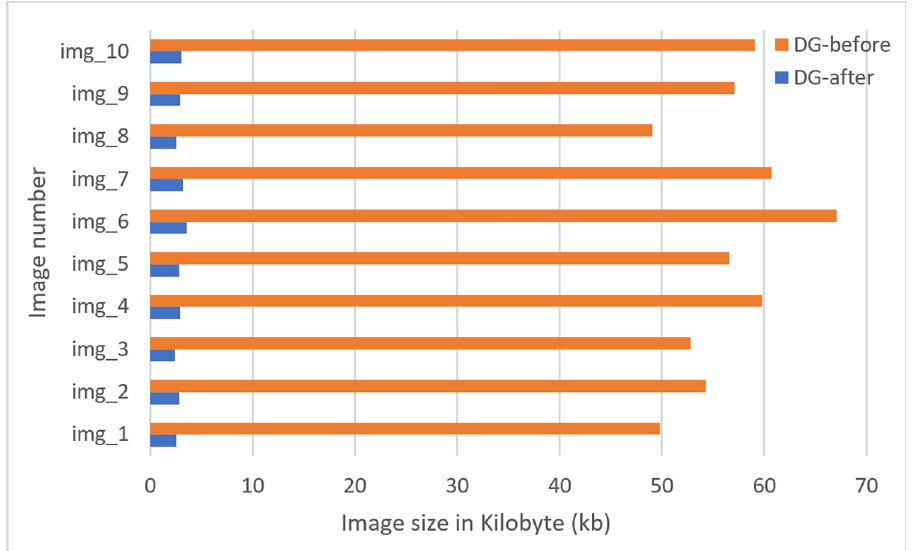
Fig 28. Storage comparison for 10 images individually for both ‘DG-before’ and ‘DG-after’ where ‘DG-before’ indicates the dataset before applying down-scaling and ‘DG-after’ indicates the dataset generated after down- scaling.